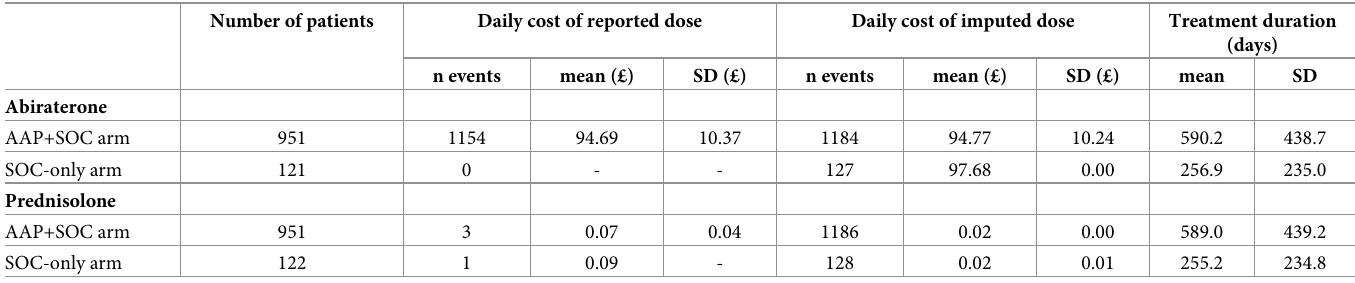
Table 3. Mean daily undiscounted per-patient costs of AAP: Raw reported doses and imputed doses. Number of